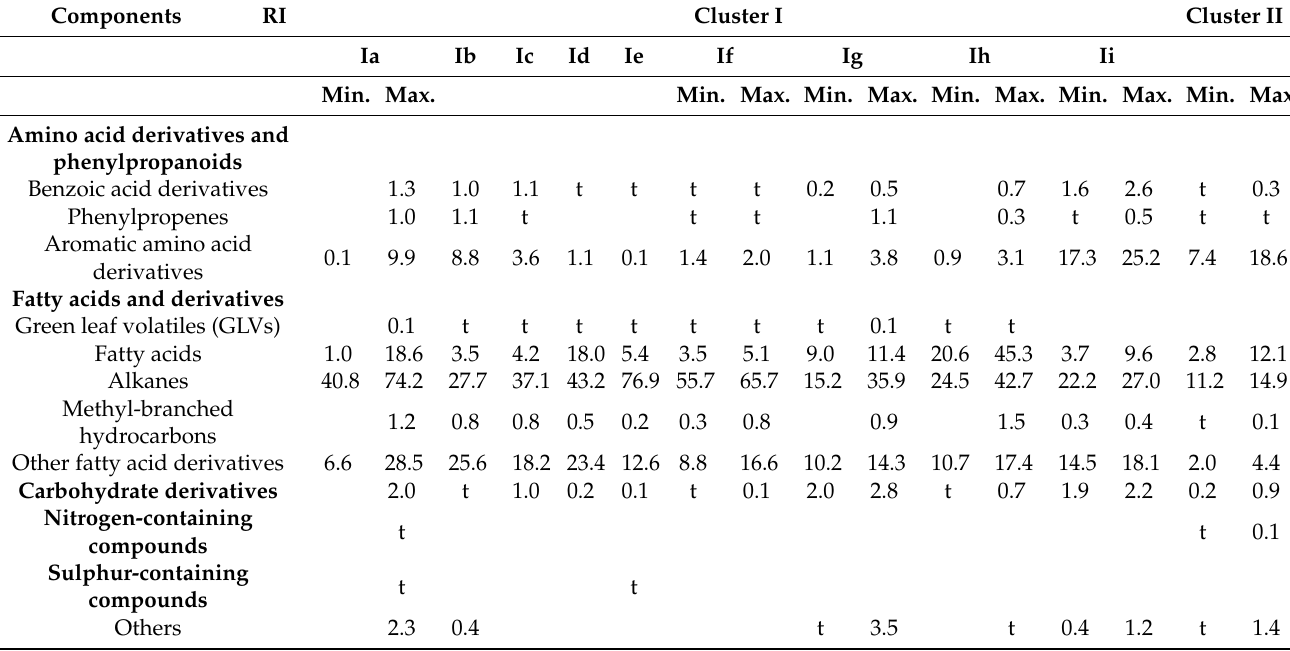
Rape honey samples were positioned in different sub-clusters, R1 in Ie and R2 in Ia, showing moderate correlation between them (Scorr <